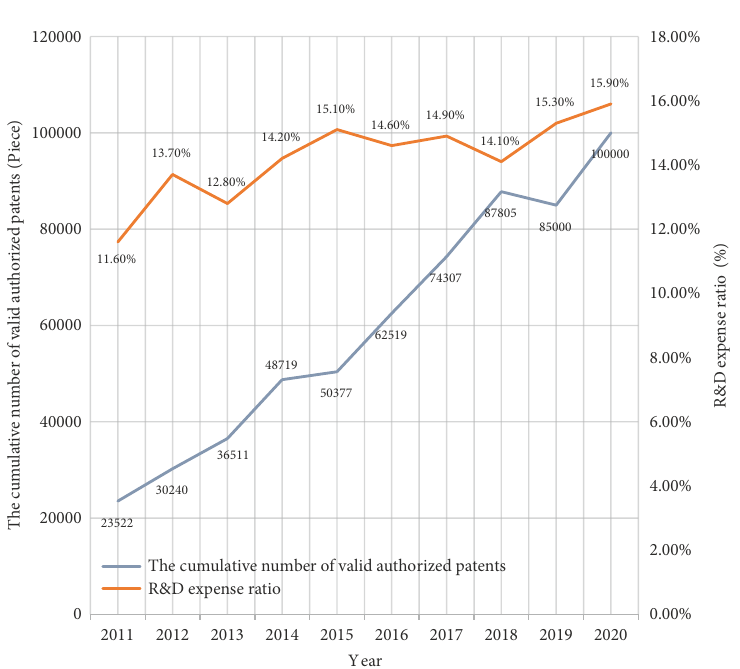
Figure 12. The cumulative number of valid authorized patents and R&D expense ratio